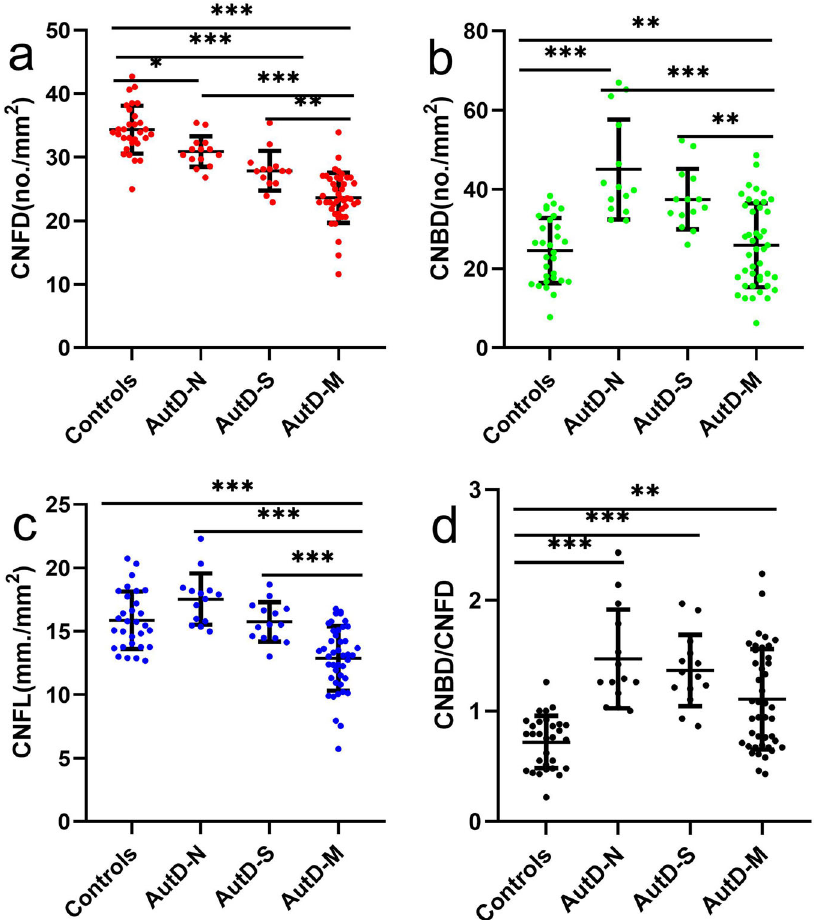
Fig. 3 CCM measurements in controls and PD patients with varying degree of autonomic dysfunction. CNFD, CNBD, CNFL, and CNBD/ CNFD ratio in AutD-N, AutD-S, and AutD-M groups were compared with controls ( a – d ). Errors bars represent mean ± standard deviation (* P < 0.05, ** P < 0.01, *** P < 0.001). PD Parkinson ’ s disease, AutD-N patients with no autonomic symptoms, AutD-S patients with single-domain autonomic symptoms, AutD-M patients with multiple-domain autonomic symptoms, CNFD corneal nerve fi ber density, CNBD corneal nerve branch density, CNFL corneal nerve fi ber length.